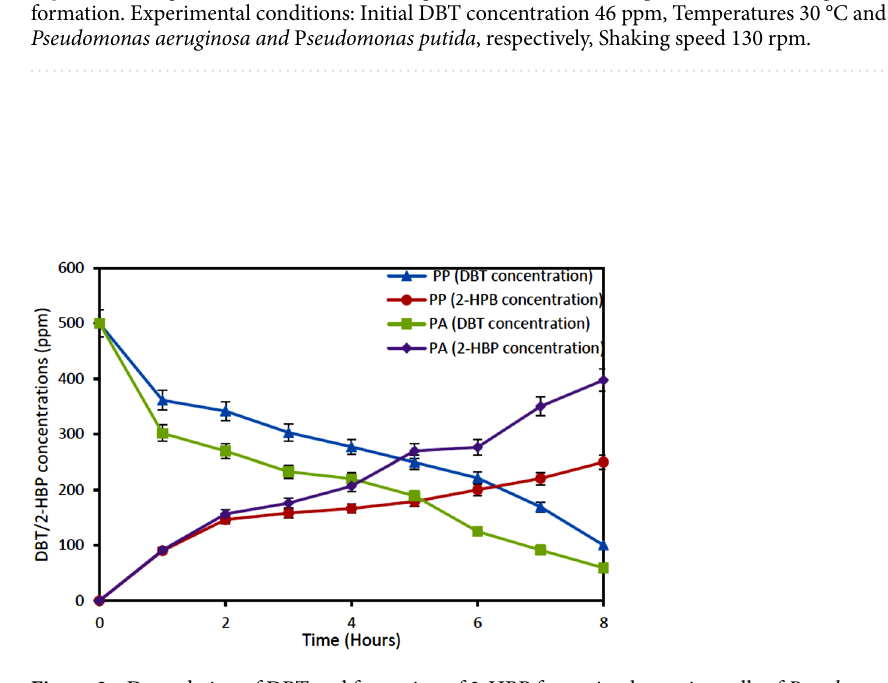
Figure 2. Degradation of DBT and formation of 2-HBP formation by resting cells of Pseudomonas aeruginosa and pseudomonas putida. Experimental conditions: Initial DBT concentration 500 ppm, Initial cell concentration 1.2 g DCW/L, Temperature 37 °C (Pseudomonas aeruginosa), 30 °C (Pseudomonas putida), Shaking speed 130